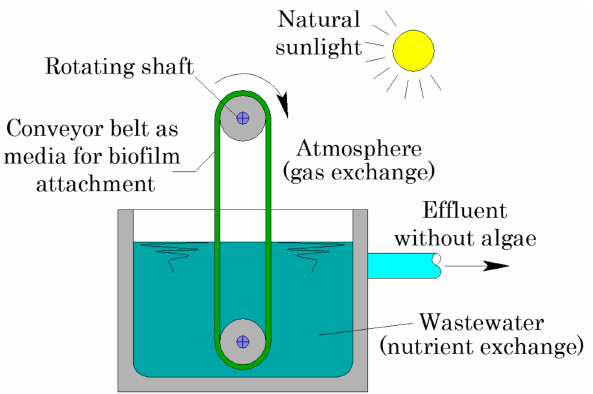
Figure 7. Vertical conveyor belt reactor scheme adapted from Zhao et al., 2018